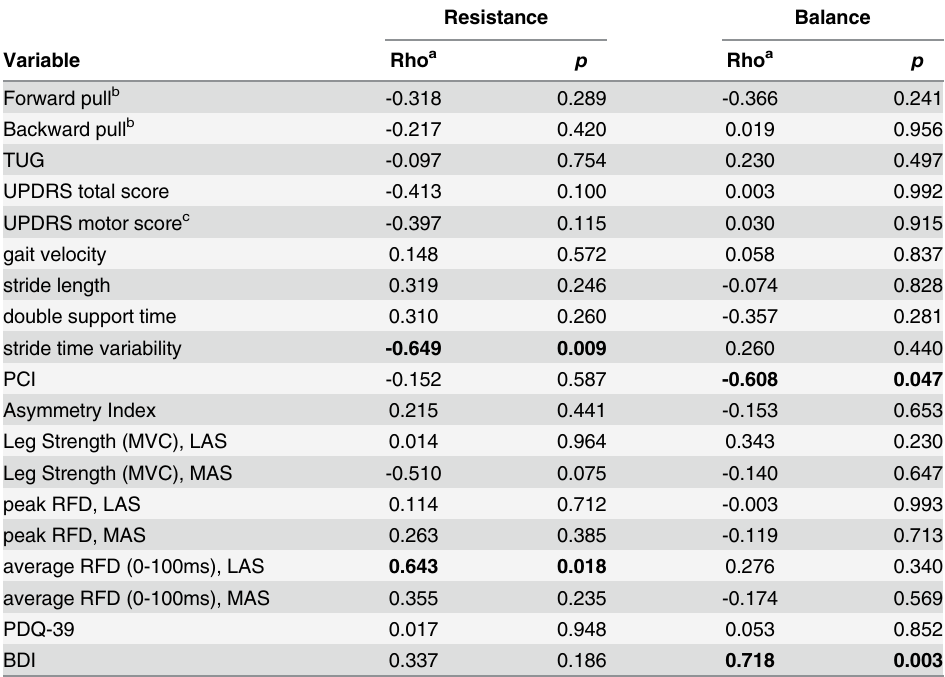
0.017 0.948 0.852 BDI 0.337 0.186 0.718 0.003 BDI, Beck Depression Inventory; FAB, Fullerton Advanced Balance; TUG, Timed-Up-and-Go-Test; LAS, less affected side; MAS, more affected side; MVC, maximal voluntary contraction; PCI, Phase Coordination Index; PDQ-39, Parkinson ’ s Disease Questionnaire; RFD, rate of force development; UPDRS, Uni fi ed Parkinson ’ s Disease Rating Scale a Spearman ’ s rank correlation coef fi cient b value represents the area under the curve of the normalized vector length from 0 – 3 sec after the surface perturbation (see Fig 2 and S3 File) c blinded video rating, without item 22